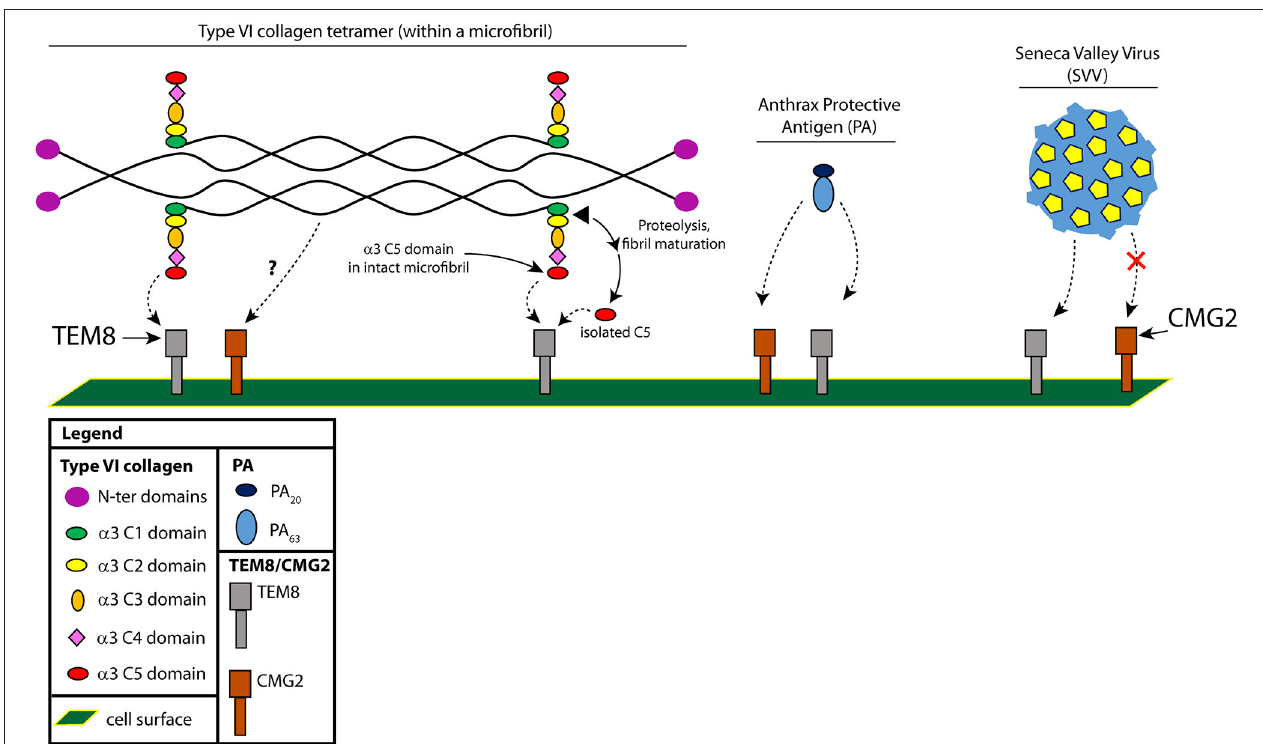
FIGURE 1 | Interactions between TEM8 and type VI collagen, Protective Antigen (PA) and (SVV). The two cell surface receptors, TEM8 and CMG2, can both bind type VI collagen and PA, but only TEM8 can bind SVV. Shown is a type VI collagen tetramer, with each chain comprising three separate α chains [ α 1(VI), α 2(VI), and α 3(VI)]. We’ve highlighted here the C-terminal portion of the α 3(VI) chain (C1-C5). The C2-C5 chains are not found in mature fibrils and are proteolytically cleaved by an unknown protease during microfibril maturation; whether C5 binds in the context of a microfibril or in the context of a cleaved C5 domain is not known, so we present both